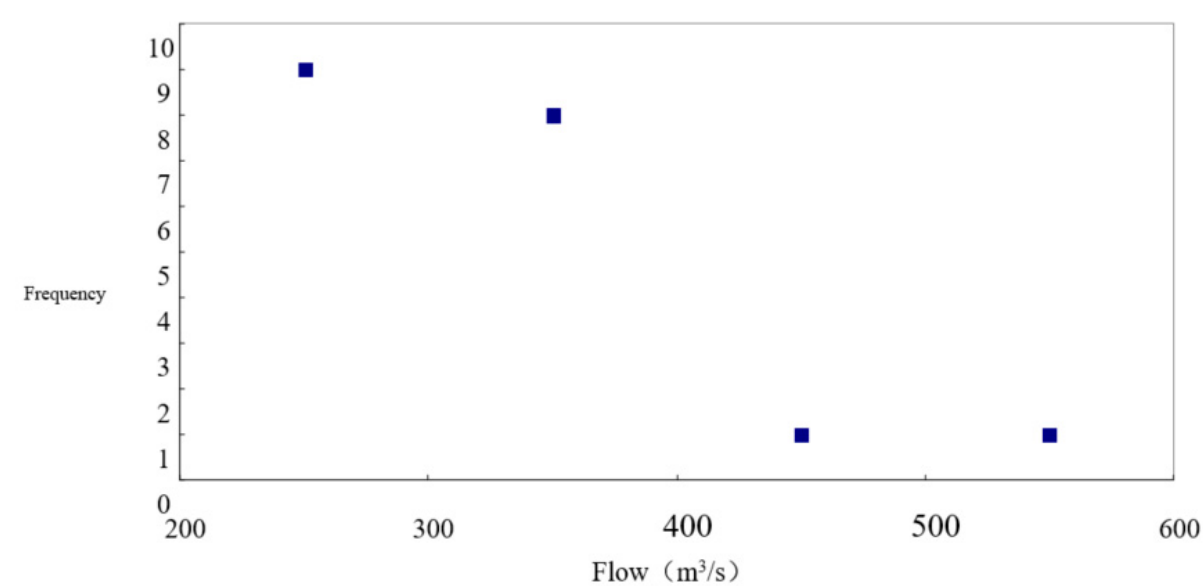
Figure 6. Value and occurred times at 75 percent with a frequency of 17 in the past 21 years (1948–1968). Source: China Water Resources Yearbook, 2018.